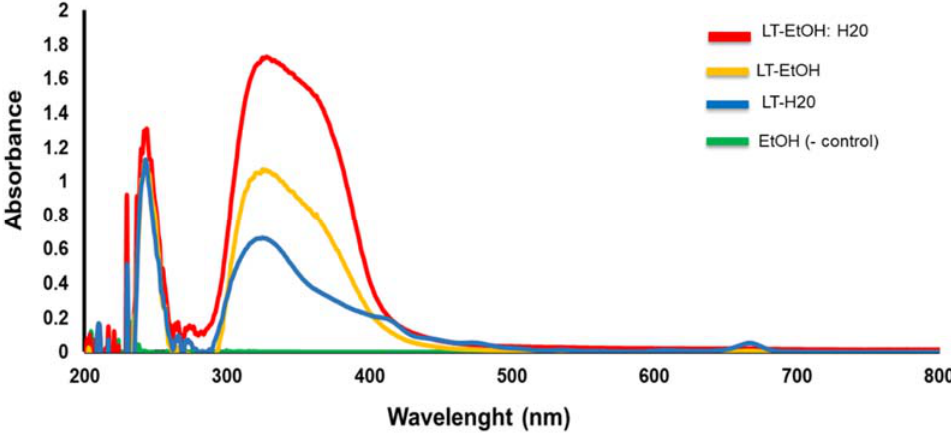
Figure 7. UV visible absorption analysis, between 200–800 nm, of LT-EtOH: H 2 O extract (red color); LT-EtOH extract (orange color) and LT-H 2 O extract (blue color). The absorption of EtOH alone (green color) was used as a negative ( − ) control.